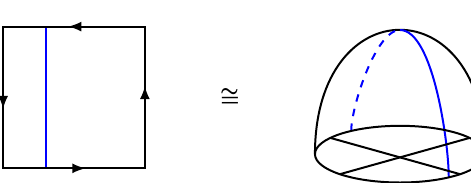
Figure 2: Projective plane with the single generator Z of its first homology class (in blue). To the right this is drawn as a sphere with a